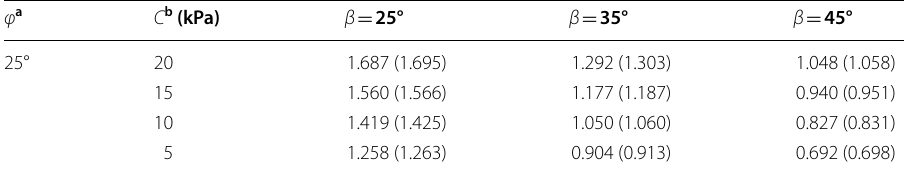
The values within and outside the parenthesis are obtained by using UB and LB method respectively a φ , internal friction angle of homogeneous soil slope b c , cohesion of homogeneous soil slope